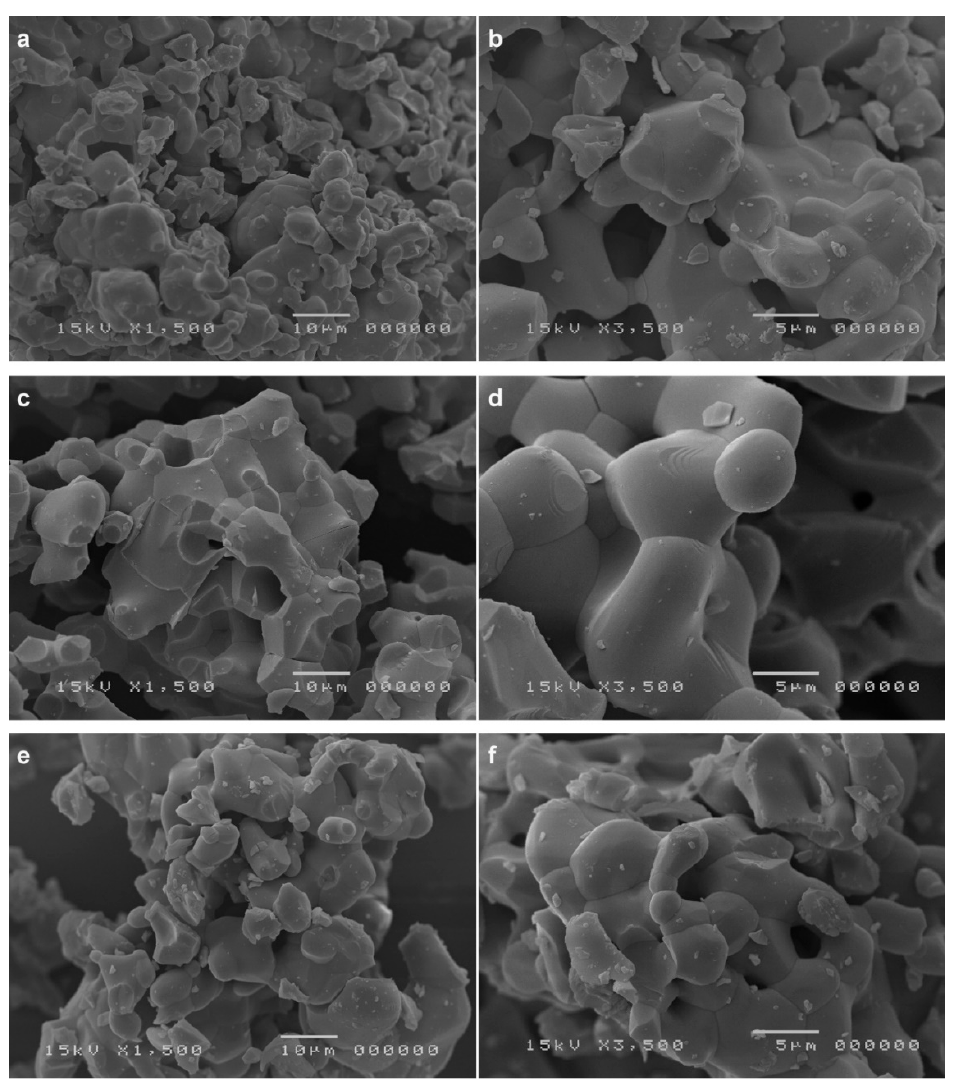
Figure 1. SEM micrographs of: ( a ) Aggregates of Mn-TCP crystals with compact and porous aggregates; ( b ) detail of aggregates of Mn-TCP; ( c ) morphology of microcrystals of Ni-TCP with detail of irregular aggregates; ( d ) particular of subspherical microcrystals of Ni-TCP with detail of growth layers and cavities between the crystals; ( e ) irregular aggregates of Cu-TCP; ( f ) aggregates of Cu-TCP composed of rounded crystals with detail of the cavities.